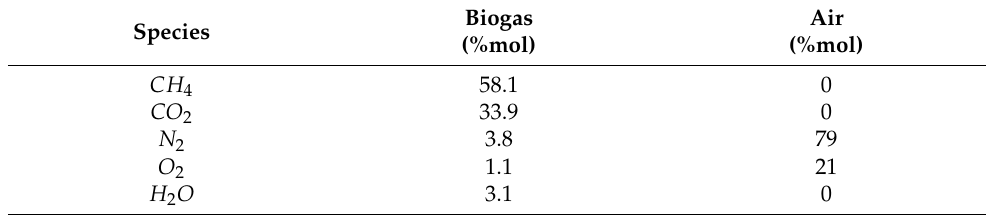
Table 1. BG and air compositions.